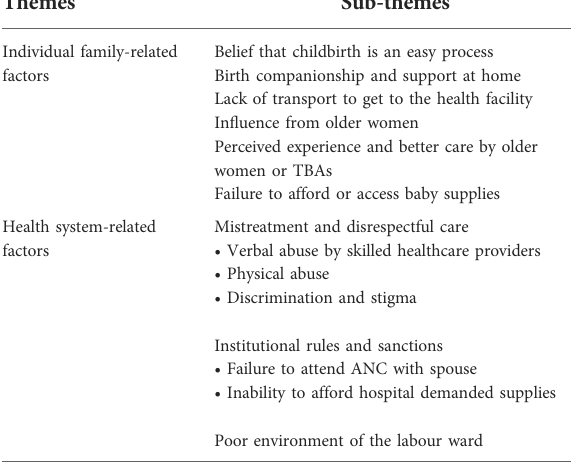
TABLE 2 Factors to care seeking for skilled birth attendance during childbirth among mothers in a selected populated community of an urban